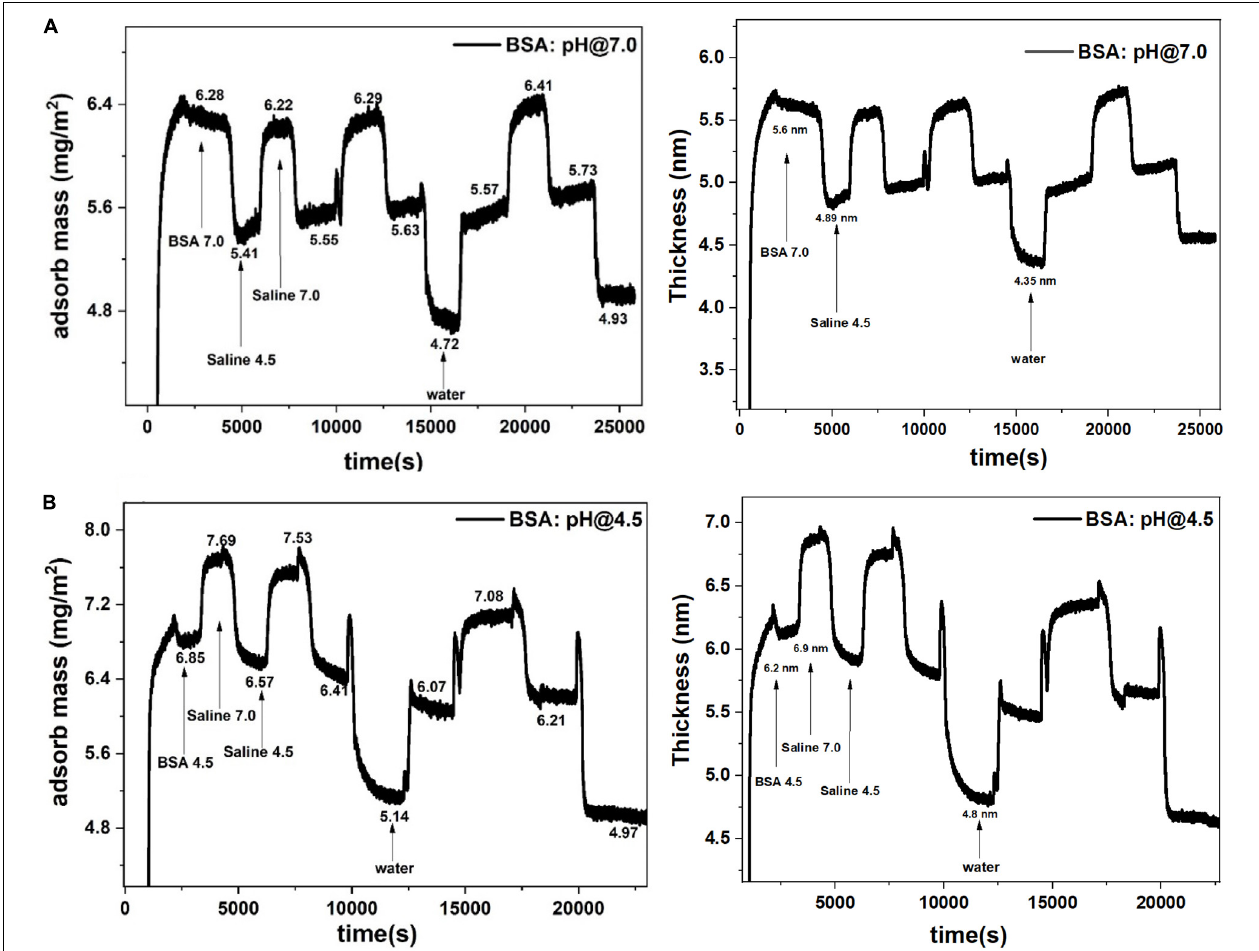
FIGURE 2 | Adsorbed BSA mass (left) and thickness (right) at the gold interface and changes with the saline rinsing cycles at pH 7.0 and 4.5. (A) BSA adsorbed at pH 7.0 and rinsed. (B) BSA adsorbed at pH 4.5 and